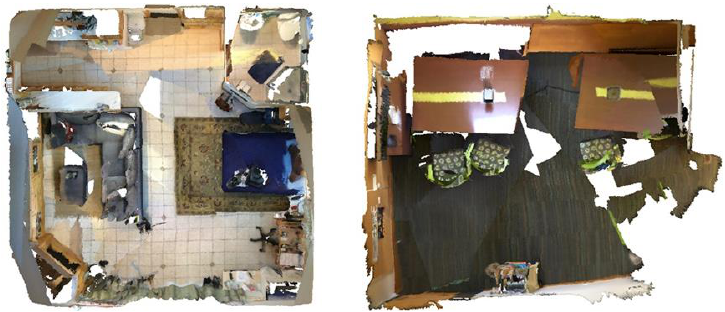
Figure 10. Visualization of semantic-segmentation results on S3DIS datasets area 5.